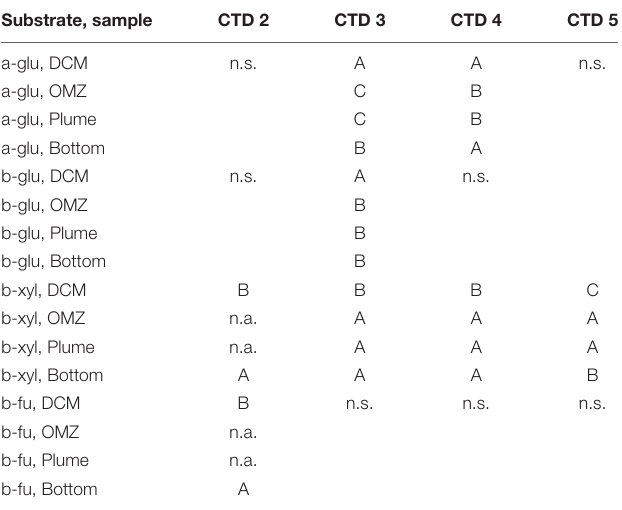
TABLE 2 | Results from post hoc comparison of depth-specific differences in exo-acting enzyme activities following a one-way ANOVA or a T -Test (CTD 2 only) with p < 0.05.